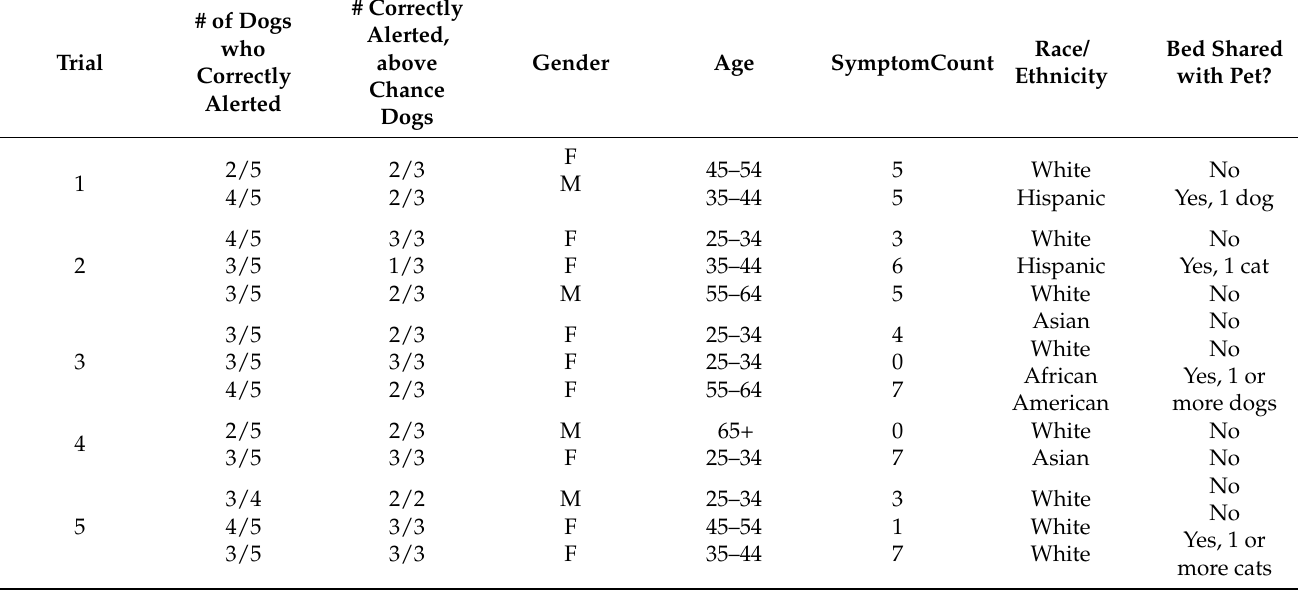
Table 6. Trial set individual positive